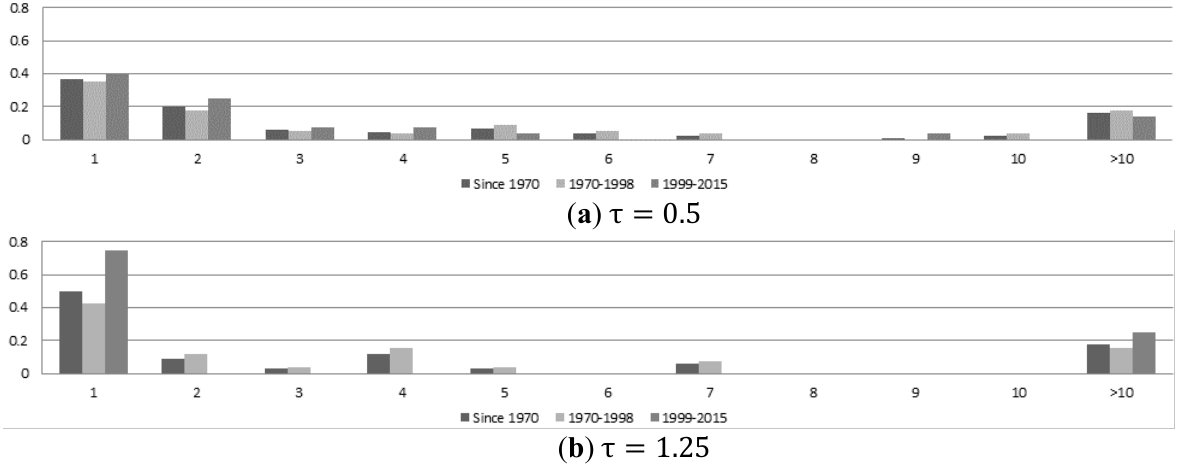
for selected severity ( a